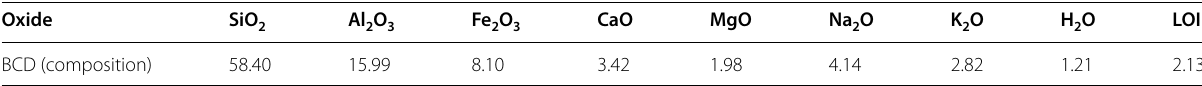
Table 6 Chemical composition of crushed